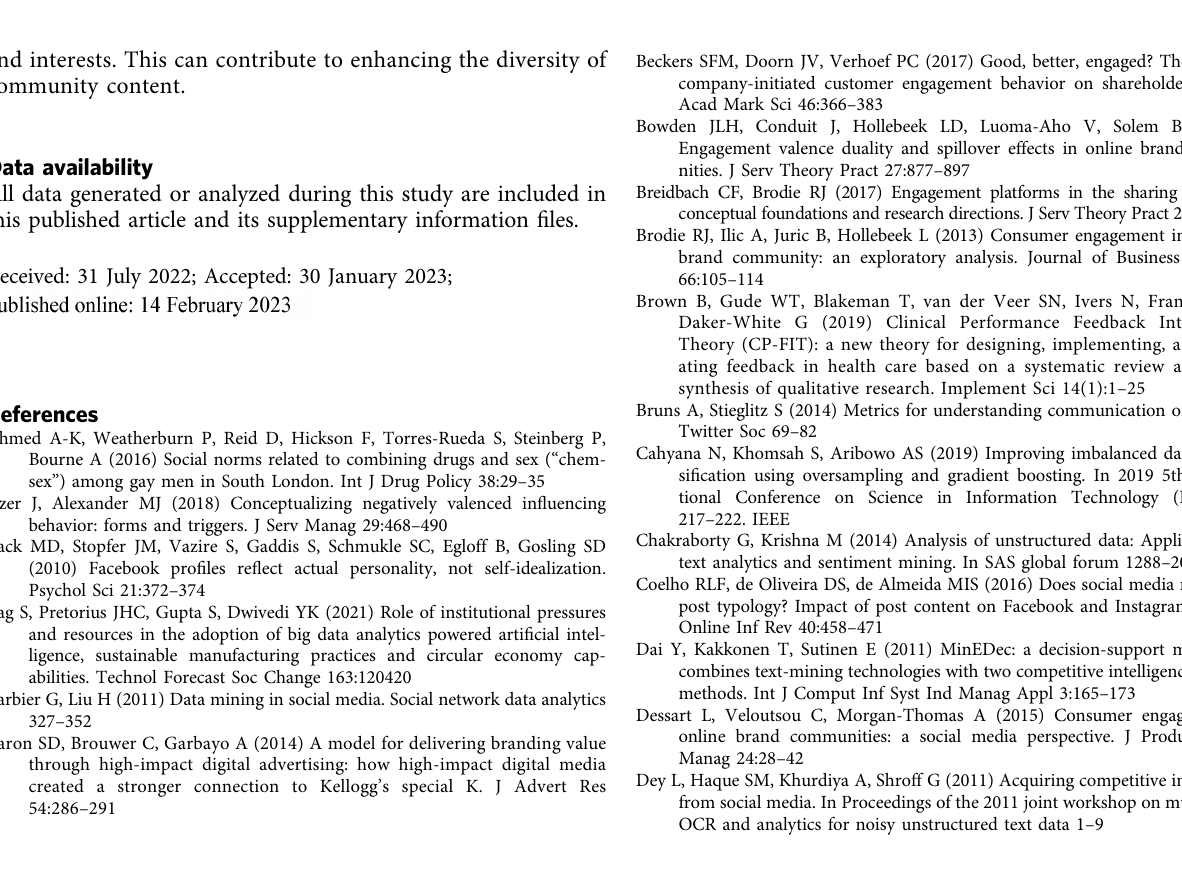
Fig. 11 Cues of Google, positive and negative clues in the postings on the “ Google ” fan